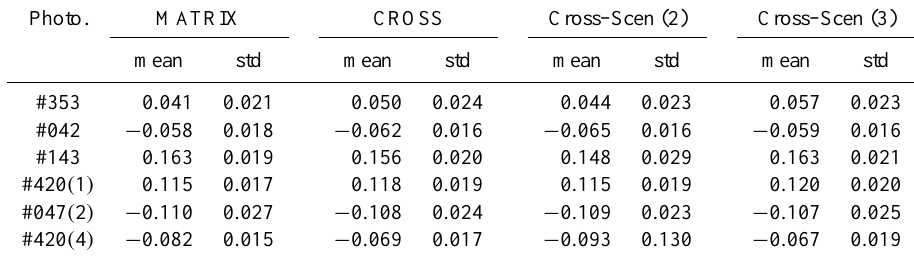
Table 2. Summary of the horizontal pointing error ( 2 ξ tests.